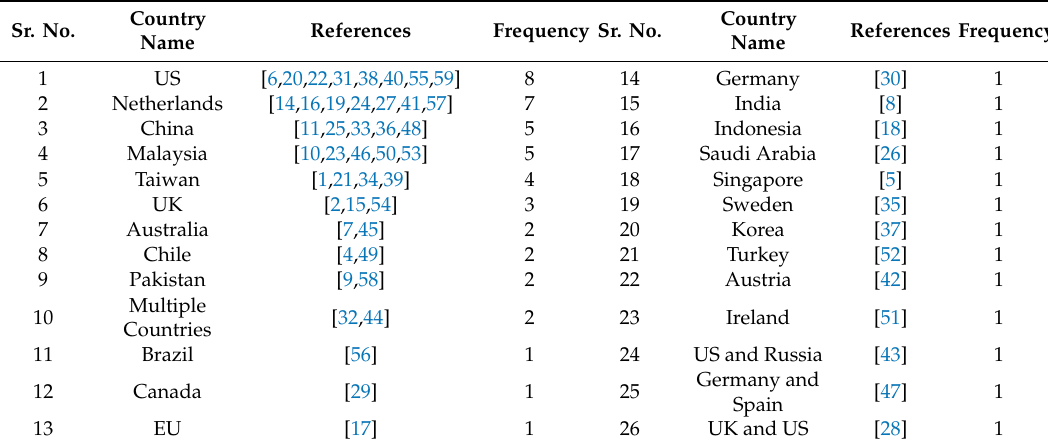
Table 6. Geographical Distribution of Studies.